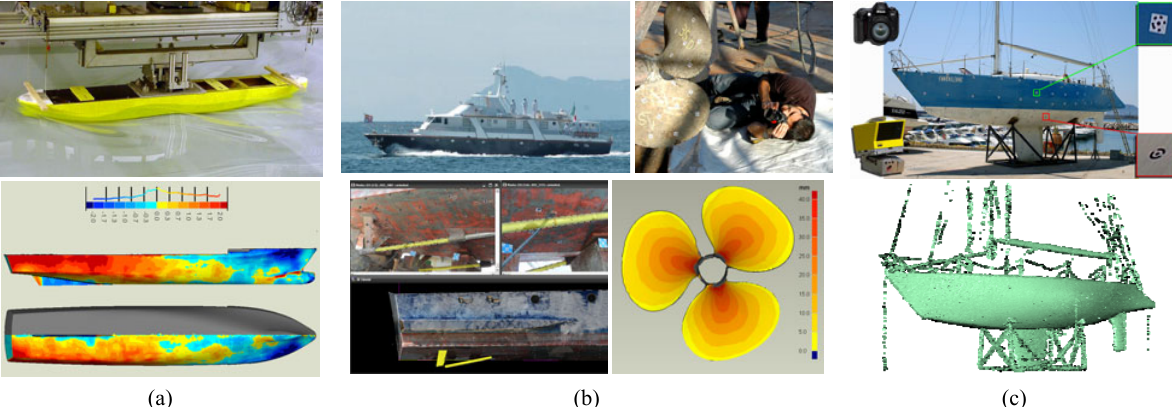
Figure 1: Examples of maritime applications within the OptiMMA project. a) Symmetry analysis of a towing tank ship model. b) Reverse engineering of the Nave Argo and its screws. c) Reverse engineering of shapes of a sailing